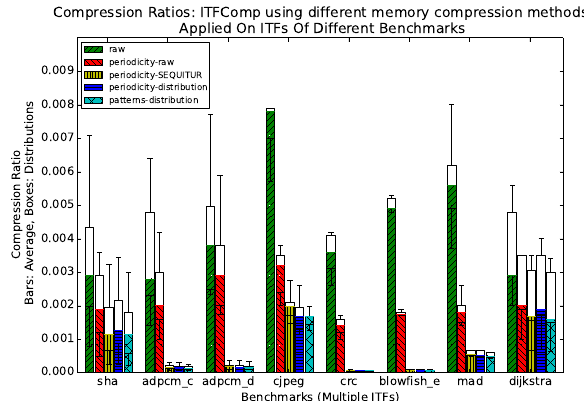
Figure 2: The compression ratio of ITFComp using different data memory addresses compression methods. Multiple ITFs of different benchmarks were used as an input.